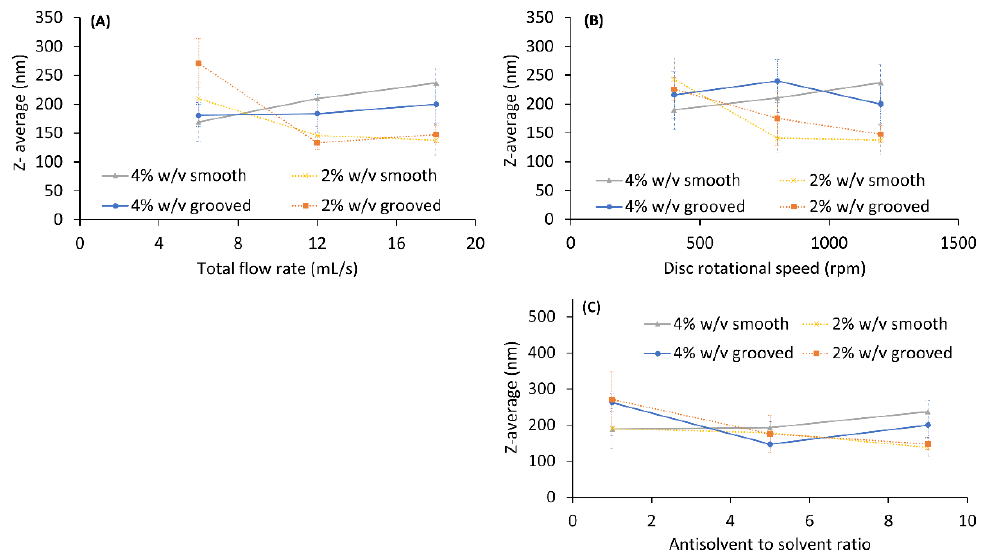
Figure 12. Overall PSD showing effect of concentration at 18 mL/s, 1200 rpm, and 9:1 ratio on the grooved disc.